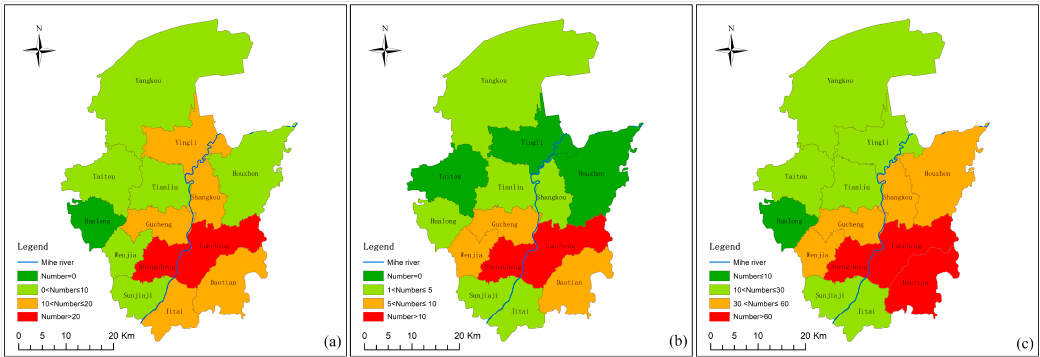
Figure 8. The spatial distribution of flood-related Weibo on different topics. ( a ) Disaster information; ( b ) rescue information; ( c ) public sentiment.